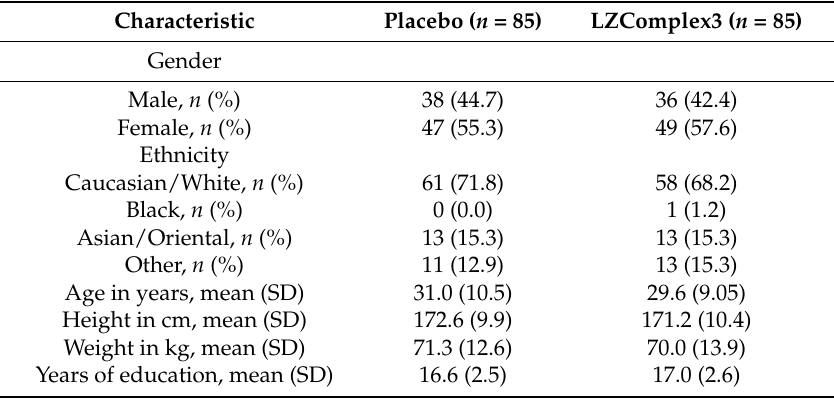
Figure 2. Participant flow. AE = adverse event, PSQI = Pittsburgh Sleep Quality Index Table 3. Demographic and other baseline characteristics (safety population; n = 170).